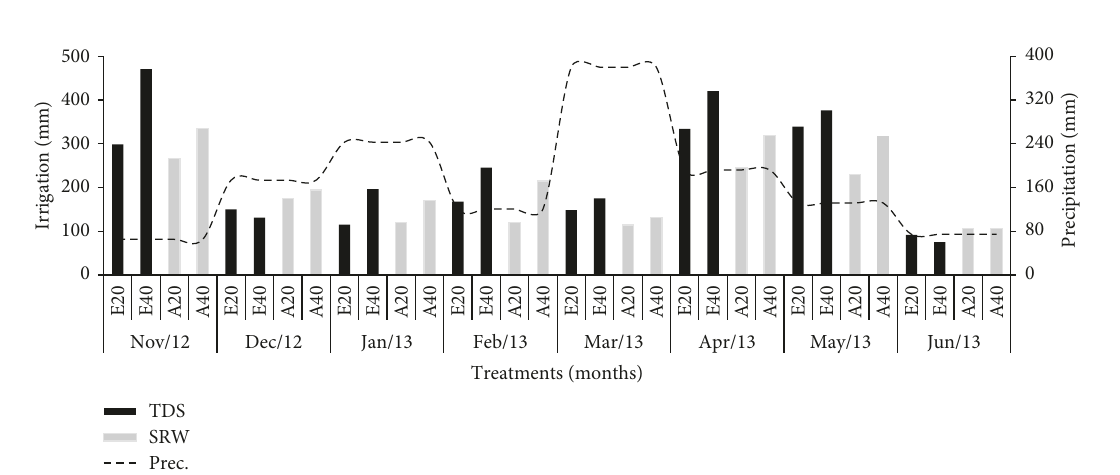
Figure 1: Effective precipitation (mm) and irrigation (mm) applied in each treatment by the time of the first sugarcane